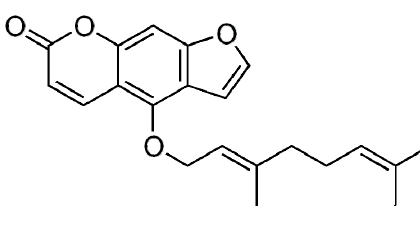
Figure 1. Structure of bergamottin.